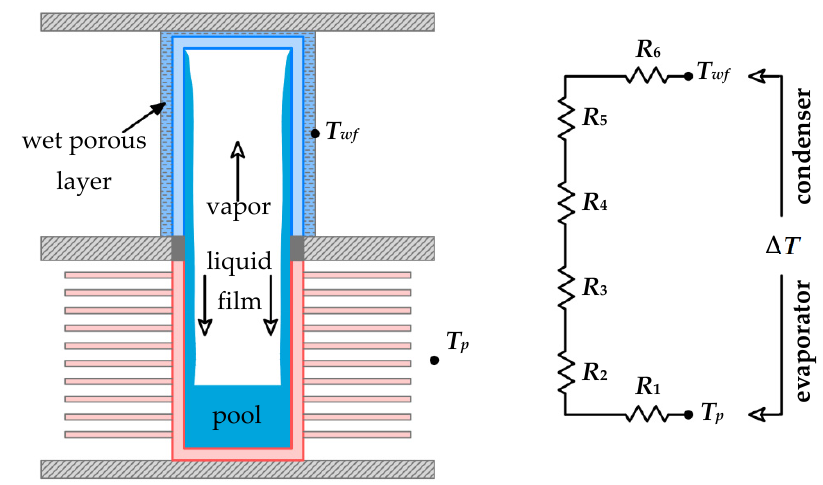
Figure 3. Schematic of a GAHP and its thermal resistance network.